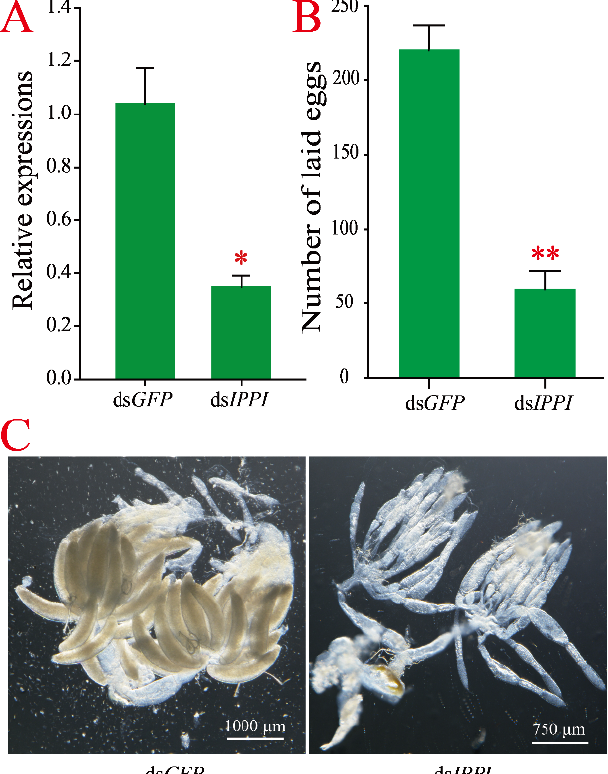
Figure 4. Comparisons of the S. furcifera treatment group (ds IPPI ) and control group (ds GFP ). ( A ) Effects of SfIPPI silencing at the transcription level; ( B ) effects of SfIPPI silencing on reproduction; ( C ) effects of SfIPPI silencing on ovary development. Significant differences between the treatment and the control groups are indicated by asterisks (* p < 0.05 and ** p < 0.01).